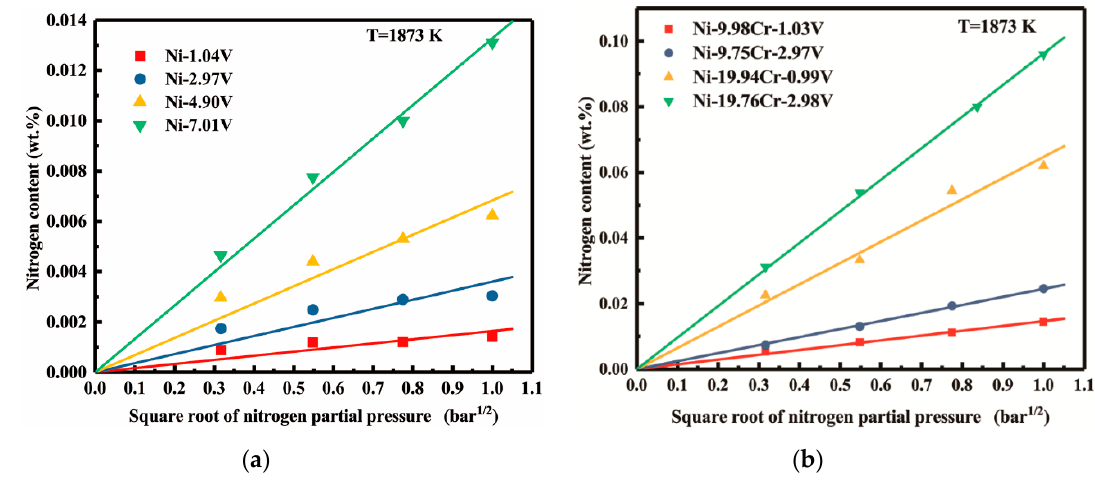
Figure 4. ( a ) Nitrogen solubility in liquid Ni-V alloys at 1873 K; ( b ) Relationship between square root of nitrogen partial pressure and nitrogen content in Ni-Cr-V alloys at 1873 K. Table 4. Sieverts’ constant Ks and the square of Pearsons correlation coe ffi cient r 2.